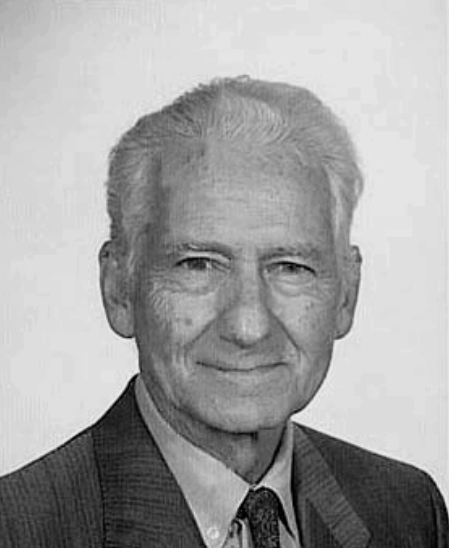
Figure 14. Pierre A. Lambert, French psychiatrist, a pioneer in the field of psychopharmacology.